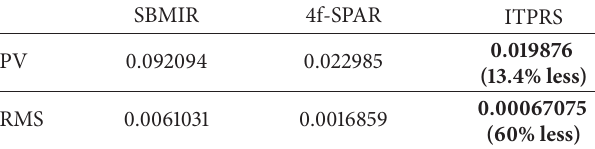
Table 1: The PV and RMS of different